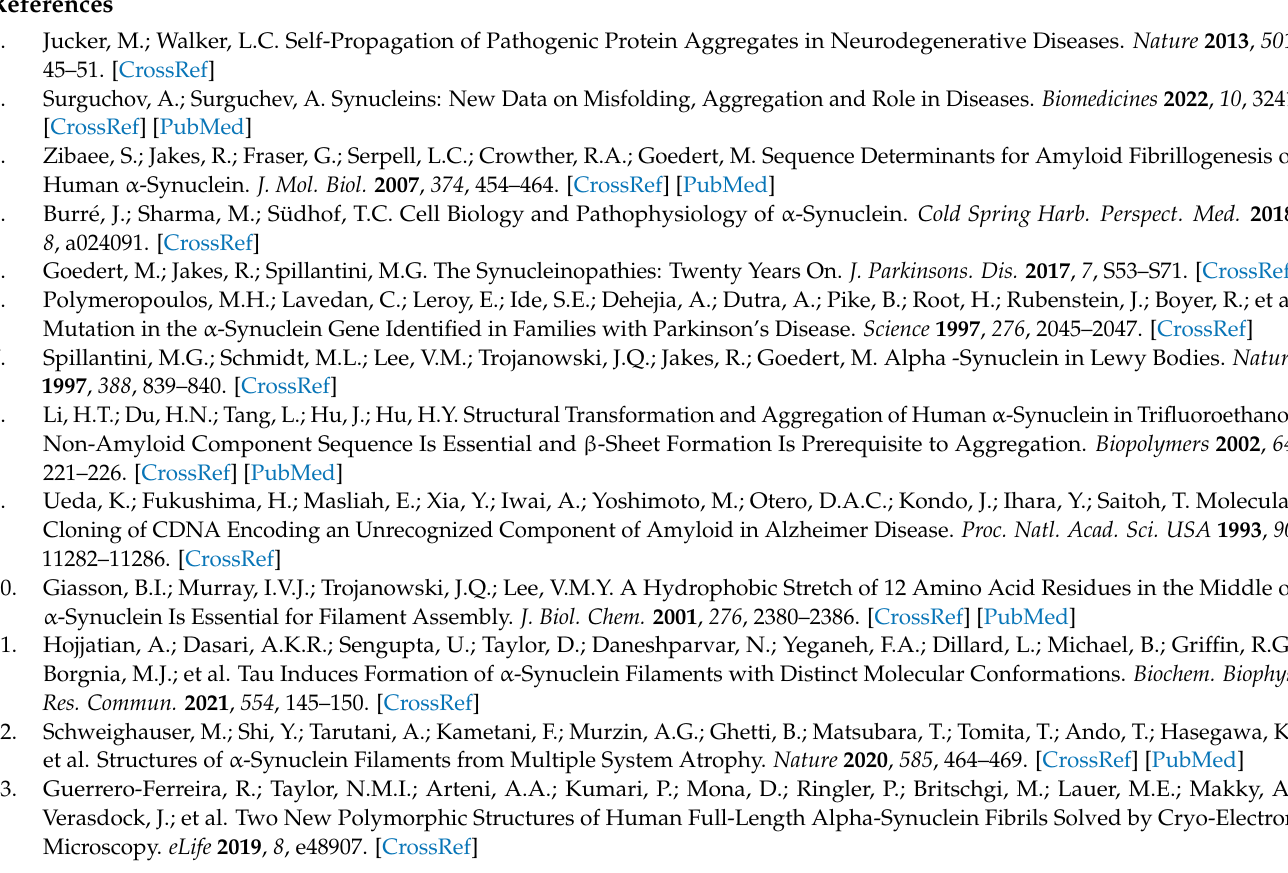
simulation; Figure S4. Backbone hydrogen bonds analysis from CMD simulation; Figure S5. Changes in the secondary structure as a function of time; Figure S6. The changes of force over the reaction coordinate; Figure S7. Changes in the secondary structure as a function of time; Figure S8. Changes of the force over the reaction coordinate; Figure S9. Changes in the secondary structure as a function of time; Figure S10. Changes in the secondary structure as a function of time; Figure S11. Changes in the secondary structure as a function of time; Figure S12. The residue interaction network